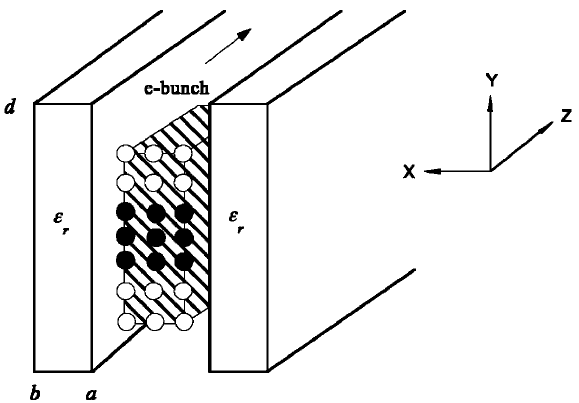
FIG. 1. Schematic slab bunch within a planar wakefield struc- ture with a height of 2 d , a channel width of 2 a , and a dielectric slab thickness of ( b - a ). All circles stand for test particles in the (decelerated) drive bunch while only filled circles stand for test particles in the accelerated